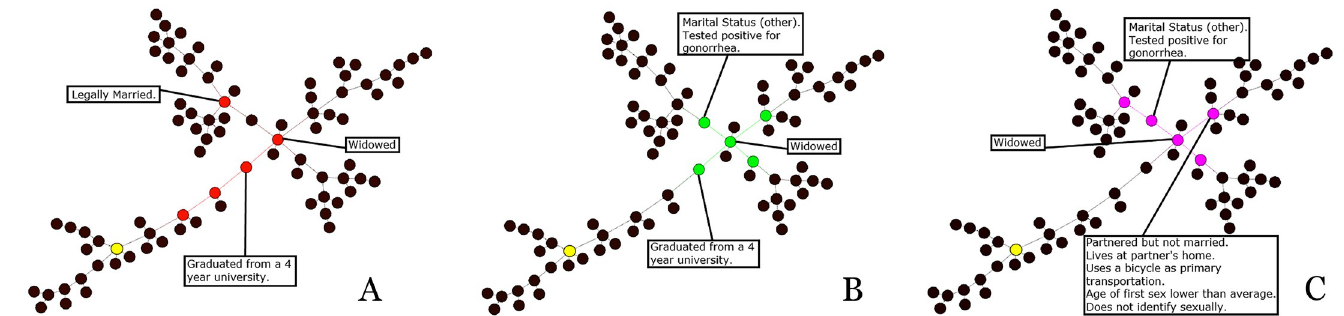
Fig 4. One component from the Raleigh-Durham referral network, with nodes highlighted by centrality. A . Betweenness. B . Closeness. C . Eigenvector.